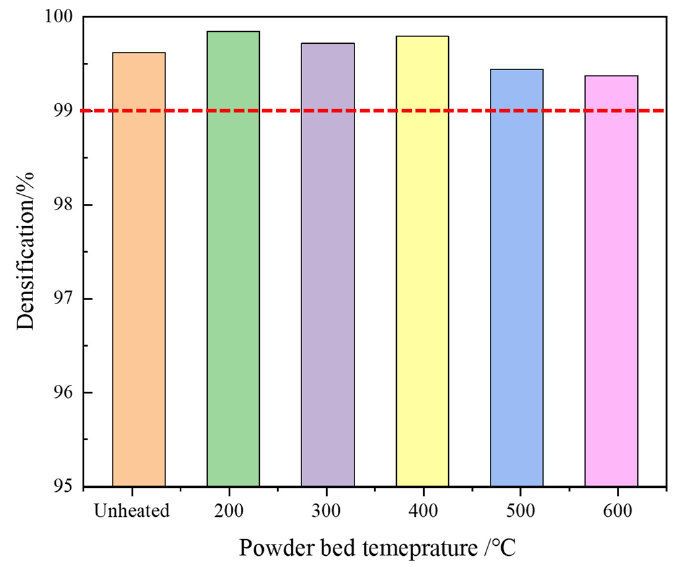
Figure 3. The densification ratio of the Ti-6Al-4V alloy samples manufactured at different powder bed temperatures.